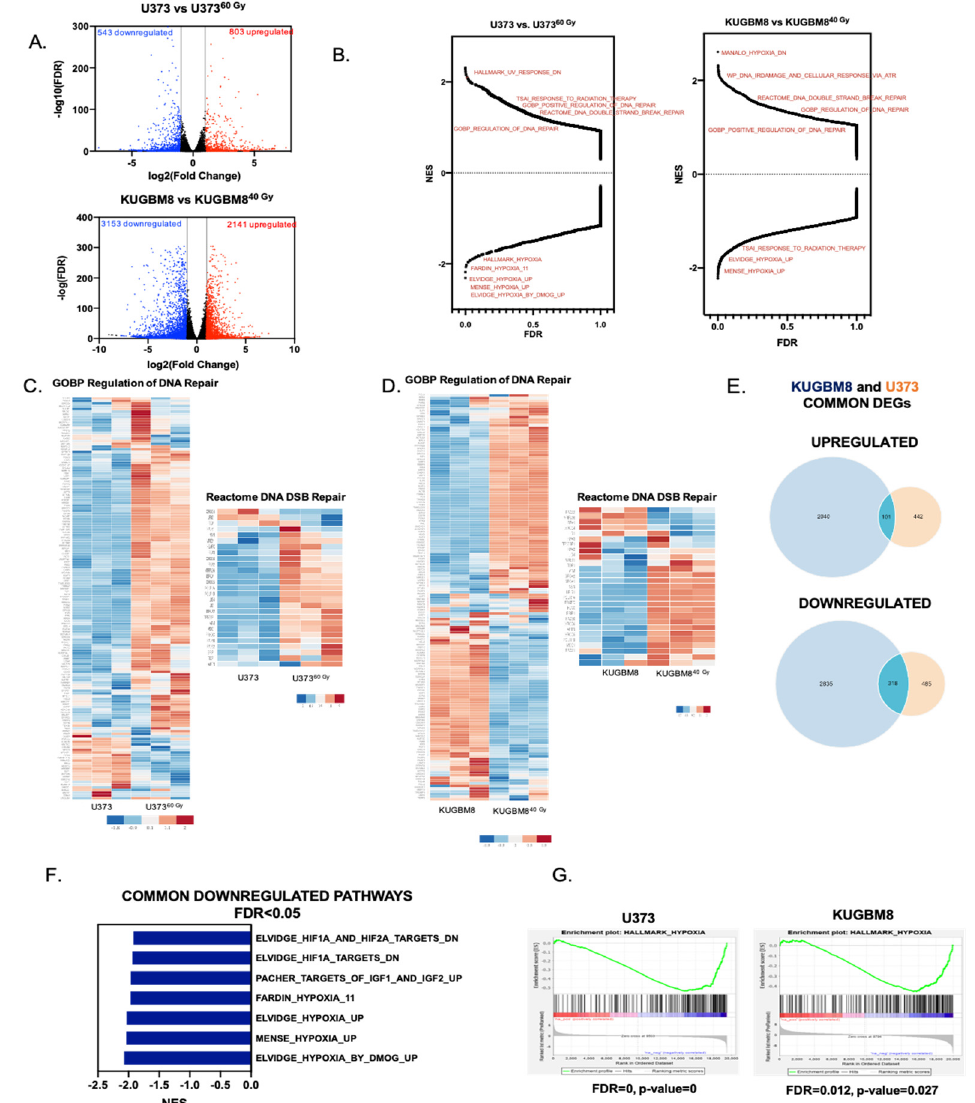
Figure 3. Transcriptomic alterations in IR-Surv cell populations. ( A ) Volcano plot showing the upregulated (red) and downregulated (blue) genes in IR-Surv U373 and KUGBM8 cells (Log2fold change > 1 and FDR < 0.05) ( B ) Gene Set Enrichment Analysis (GSEA) plots of U373 and KUGBM8 cells showing the distribution of all available gene sets. ( C , D ) Differential expression heat map of GOBP Regulation of DNA Repair and Reactome DNA DSB Repair gene sets for U373 and KUGBM8 cells. Heat map showing z-score of log2 transformed gene expression of selected genes. ( E ) Number of commonly and differentially upregulated (top) or downregulated (bottom) genes between U373 and KUGBM8 cells and their IR-Surv cell pairs. ( F ) Commonly downregulated gene sets between U373 and KUGBM8 cell pairs. ( G ) Representative enrichment plots of “Hallmark_Hypoxia” gene sets for U373 and KUGBM8 cells.